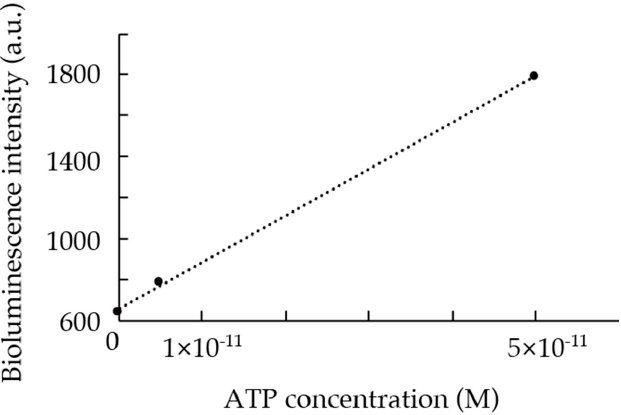
Figure 8. Relationship between ATP concentration and bioluminescence intensity measured by the in-situ ATP analyzer during the 2021st dive of HYPER-DOLPHIN. Consecutive 10 s measurements at each ATP concentration were integrated and plotted with the ATP concentration.